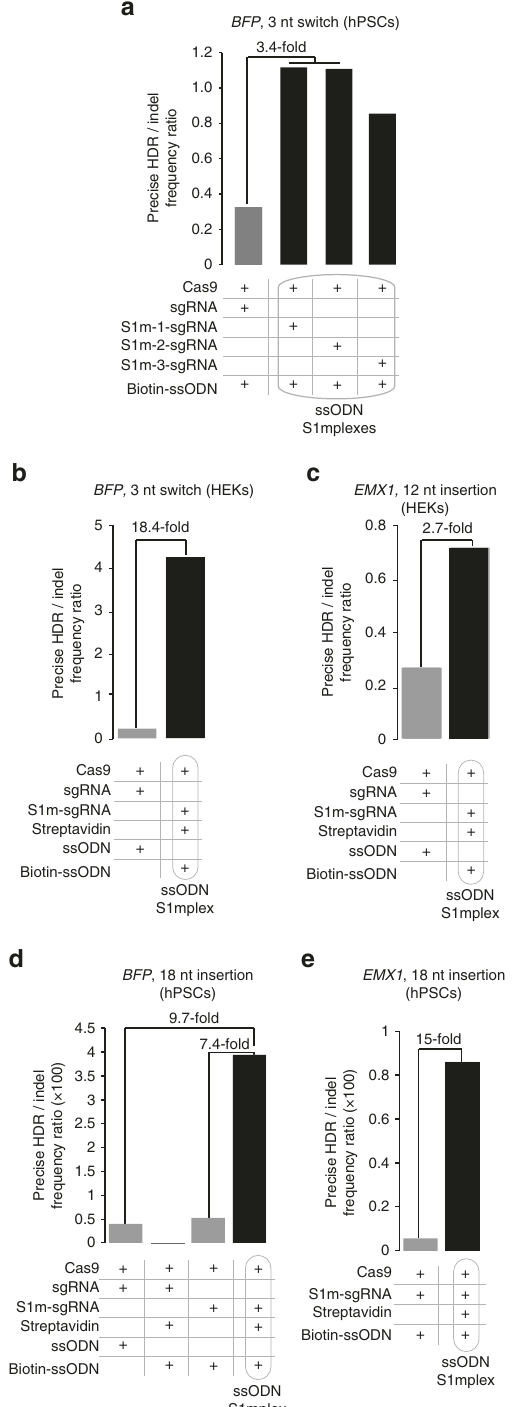
one indel as analyzed by deep sequencing 8 days post lipofection of HEKs.